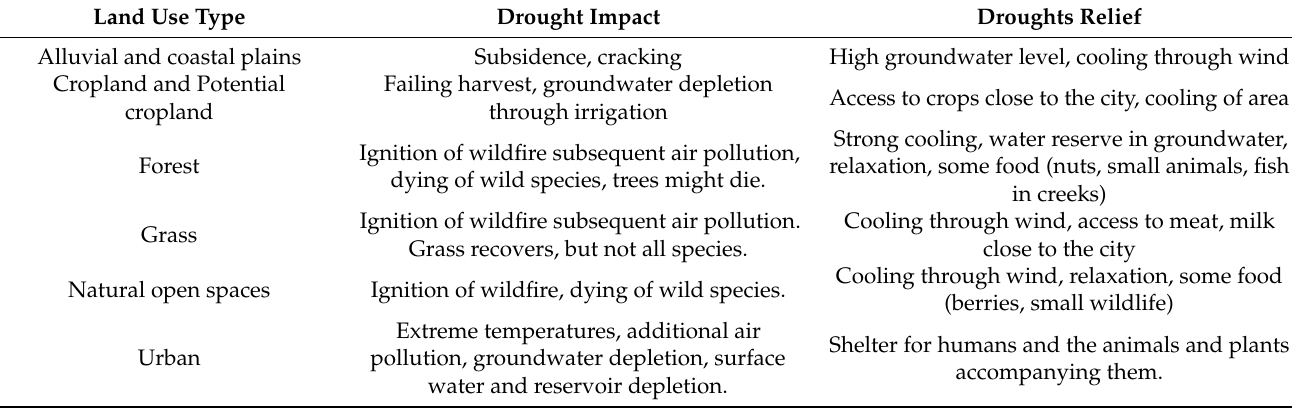
Table 1. Land use practices, possible drought impacts, and mediation methods.